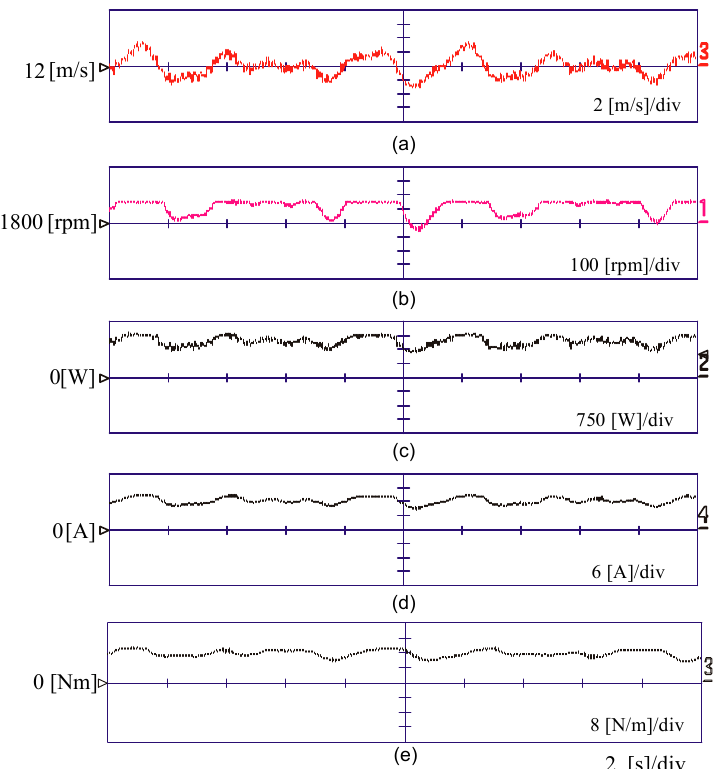
Figure 19. Turbulent wind speed: ( a ) Wind speed, ( b ) generator speed, ( c ) generator power, ( d ) q-axis current, and ( e ) and generator torque.